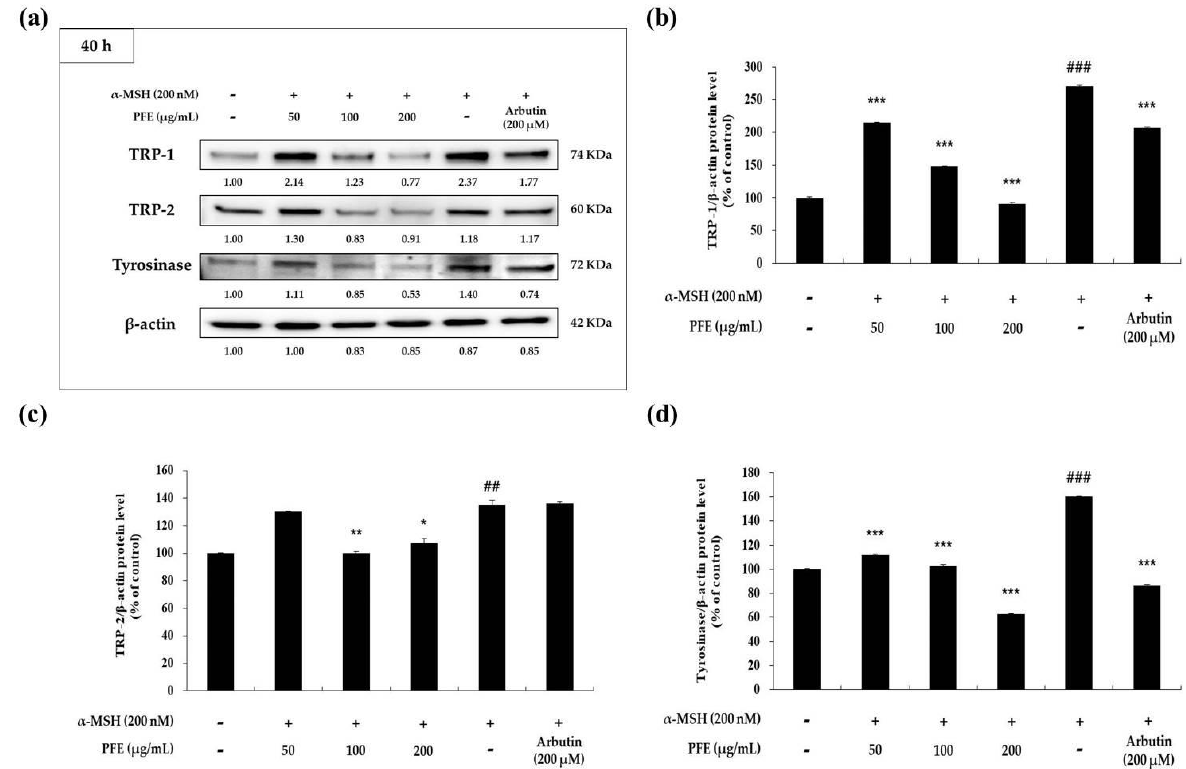
Figure 3. Variation in melanogenic enzymes expression of B16F10 cells to PFE treatment concentration. The cells, α-MSH-stimulated, were treated with the PFE and arbutin (200 μM) for 40 h. ( a ) The band of melanogenic enzymes and the graph by quantified protein levels of ( b ) tyrosinase-related protein (TRP)-1/β-actin, ( c ) TRP-2/β-actin, and ( d ) tyrosinase/ β -actin. Results in each graph are represented as the mean ± SD of at least triplicate experiments. ## p < 0.01, ### p < 0.001 vs. non-treated. * p < 0.05, ** p < 0.01, *** p < 0.001 vs. α-MSH-treated alone.